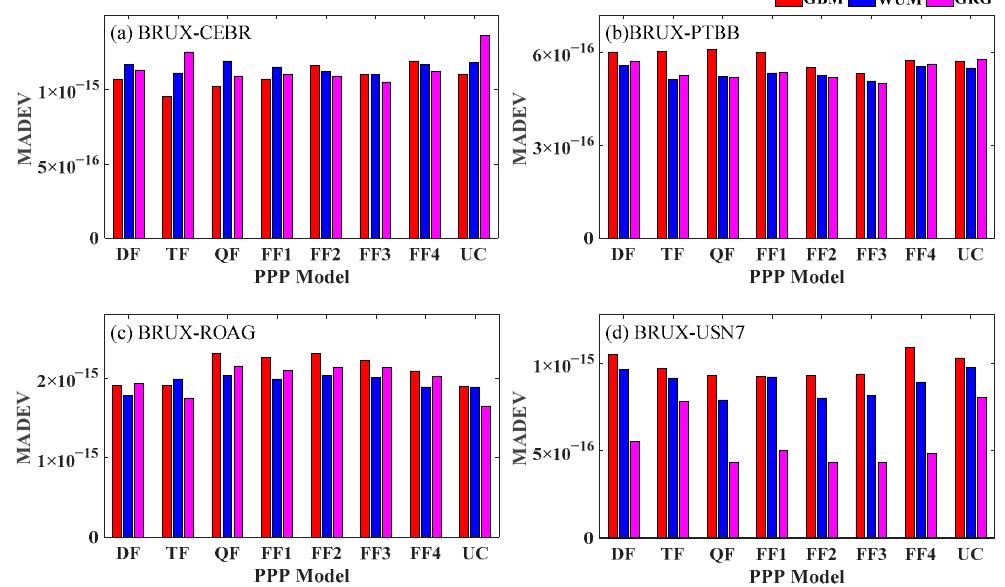
Figure 14. MADEV of the PPP solution by using GBM, WUM and GRG precision products at 120,000 s. ( a ) BRUX-CEBR time-frequency link; ( b ) BRUX-PTBB time-frequency link; ( c ) BRUX-ROAG time-frequency link; and ( d ) BRUX-USN7 time-frequency link.